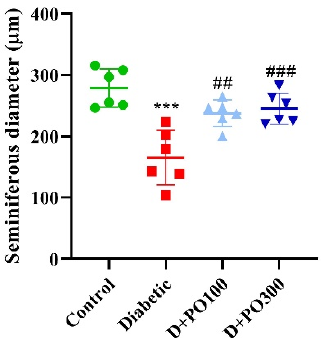
Figure 8. The effects of PO extract on seminiferous diameter in diabetic rats. The data are presented as mean ± SD. A one-way ANOVA test was carried out with the following Tukey–Kramer’s post hoc test; *** p < 0.001 vs. control group; ## p < 0.01, ### p < 0.001 vs. diabetic group. test; *** p < 0.001 vs. control group; ## p < 0.01, ### p < 0.001 vs. diabetic